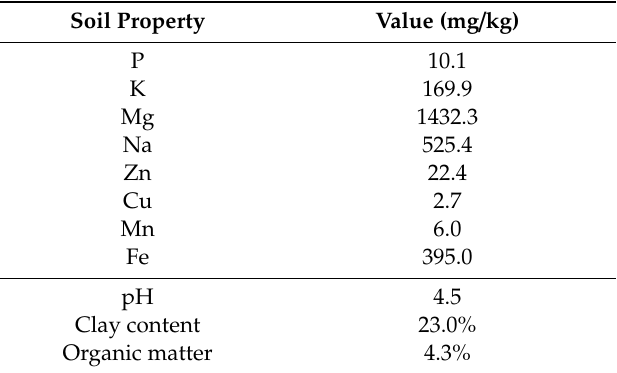
Table 5. Properties of the soil used in the